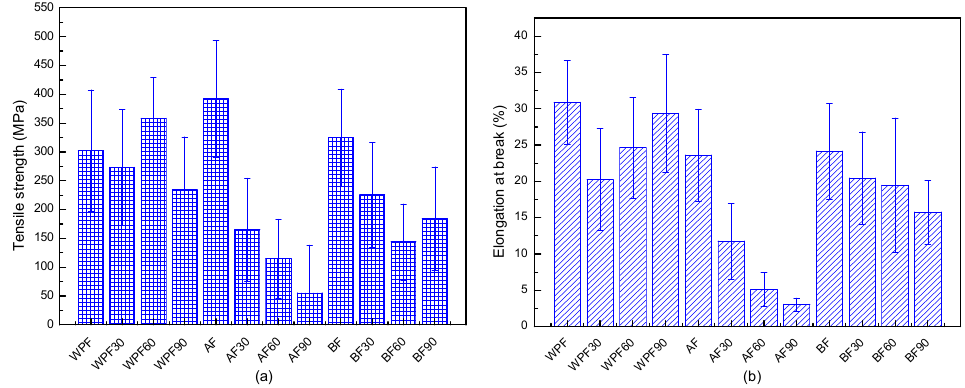
Figure 4. ( a ) Tensile strength and ( b ) elongation at break of windmill palm fiber with and without chemical treatment before and after soil burial.